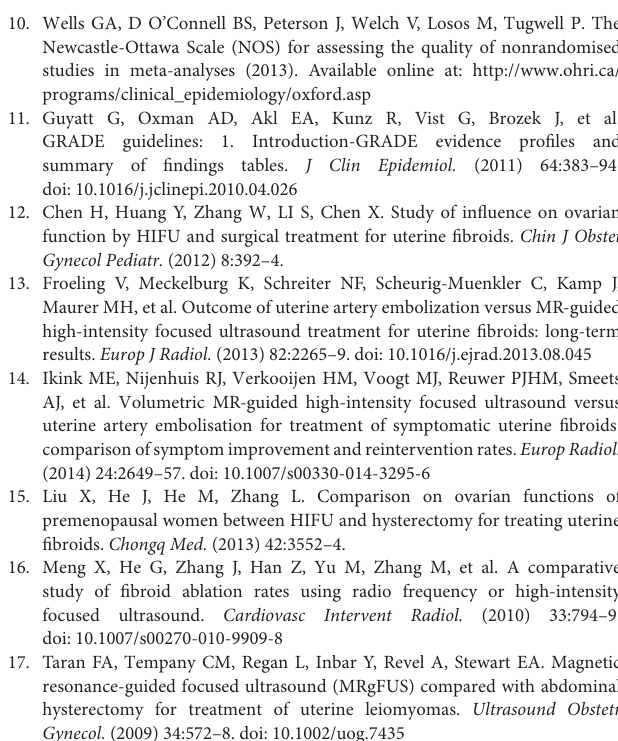
Supplementary Figure 2 | Re-intervention rate of HIFU in comparison with other techniques: sensitivity analysis. Supplementary Figure 3 | Abnormal pregnancy incidence of HIFU in comparison with other techniques: ITT analysis. Supplementary Figure 4 | Follicle-stimulating hormone (FSH) change of HIFU in comparison with other techniques. Supplementary Figure 5 | Luteinizing hormone (LH) change of HIFU in comparison with other techniques. Supplementary Figure 6 | Estradiol (E2) change of HIFU in comparison with other techniques. Supplementary Figure 7 | Fever incidence of HIFU in comparison with other techniques: sensitivity analysis.